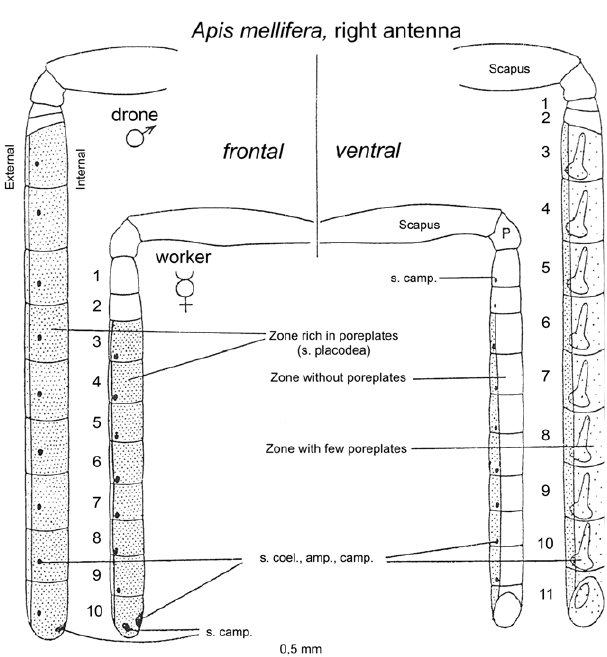
Figure 3. Schematic representation of the worker ( (cid:2) ) and drone ( (cid:3) ) right antenna in frontal (left) and ventral (right) view. The highly dotted, less dotted and empty segments correspond to segments rich, moderately rich and deprived of sensillae placodea (poreplates), respectively. Adapted from Esslen and Kaissling (1976)